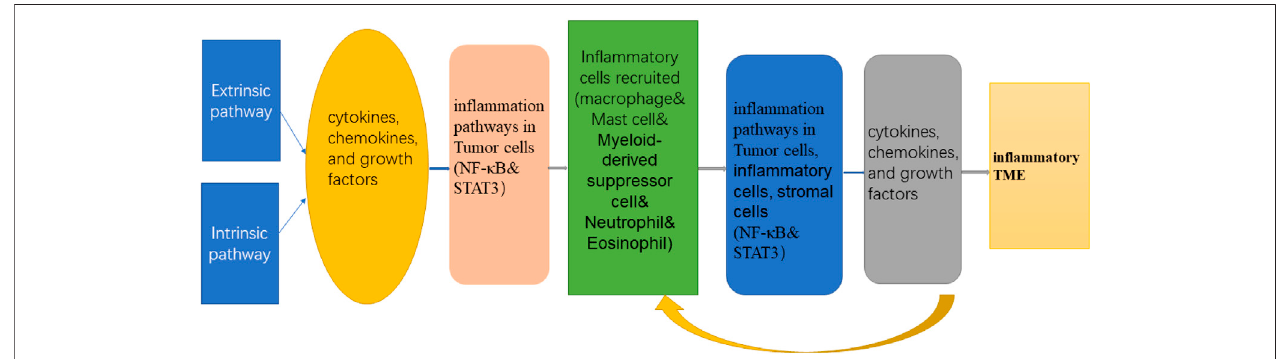
FIGURE 2 | The multifaceted connections of in fl ammation and cancer.